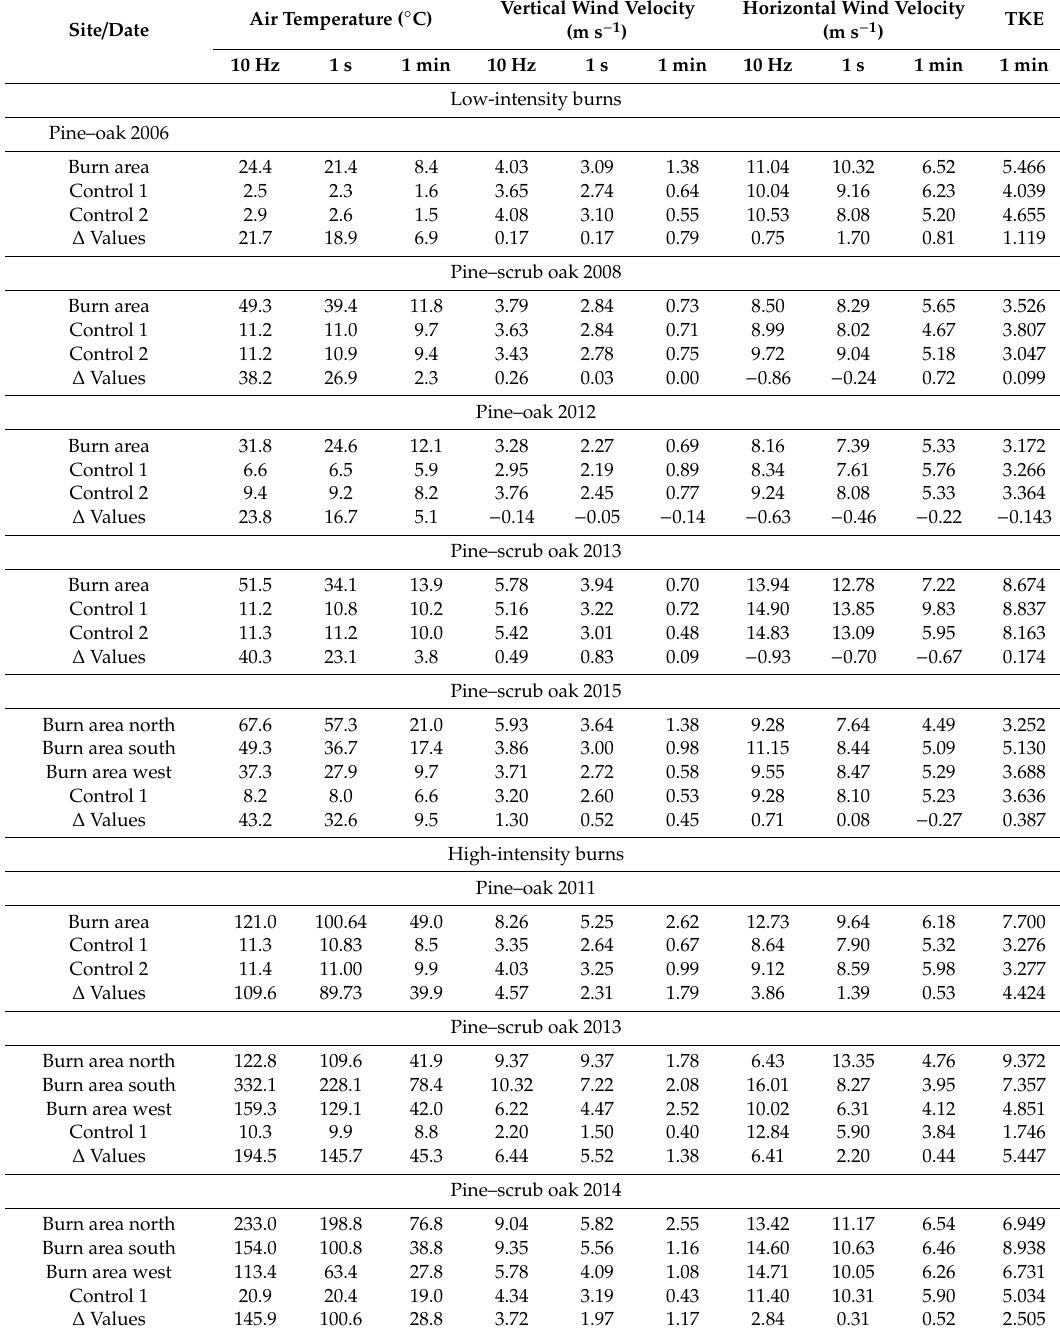
Table A2. Above-canopy air temperature, vertical wind velocities, and horizontal wind velocities measured at 10 Hz and then integrated over 1 s and 1 min averaging times on towers located in burn area and control stands during the eight prescribed